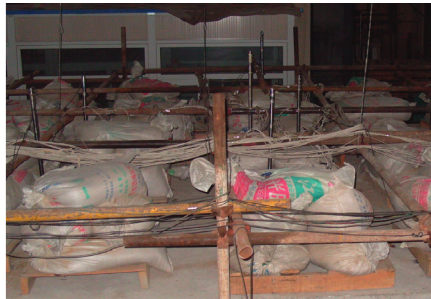
Figure 6: View of the